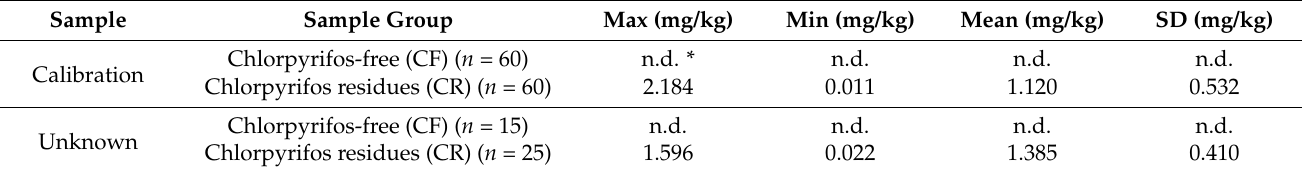
Table 3. Concentration of chlorpyrifos residues on samples for calibration and prediction stages.